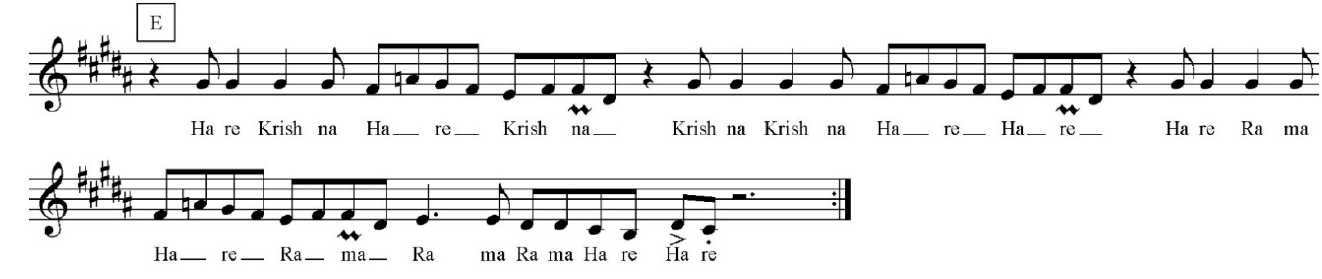
Figure 10. Melody E.